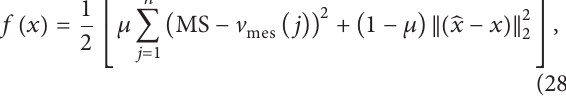
Figure 5: Comparison of the algorithm versus extended Kalman